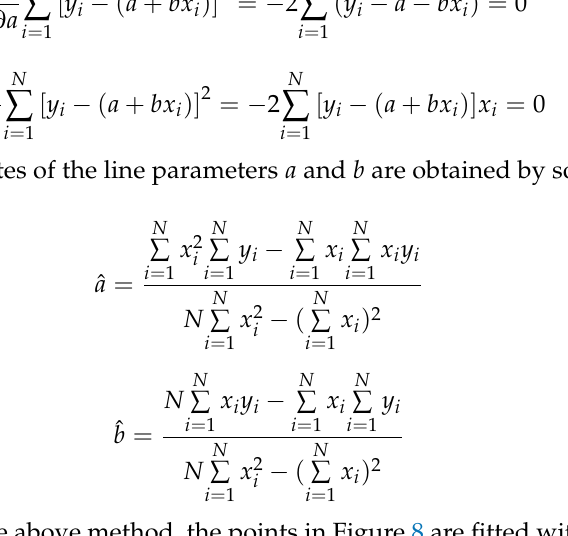
Figure 10. Image results of secondary sea-sky line extraction: ( a ) scatter fitting result; ( b ) secondary sea-sky line extraction result of the image after edge detection; ( c ) secondary sea-sky line extraction result of the original image. 5. Object Region Extraction and Local Defogging Algorithm According to the perception system of the USVs and the characteristics of the image at sea, when the marine radar guides the photoelectric equipment to point to the object, the guided object will appear in the middle area of the optical image and near the sea-sky line at the same time. Therefore, the search of the object area only needs to be determined in the above area. Extracting the object area based on the sea-sky line can significantly reduce the amount of calculation, speed up the calculation speed, and improve the detec- tion robustness. As shown in Figure 11a, the semicircular window is slid along the sea-sky line and searched by step s , and the number of bright spots in the semicircular window at each position is counted. The specific calculation is as follows.